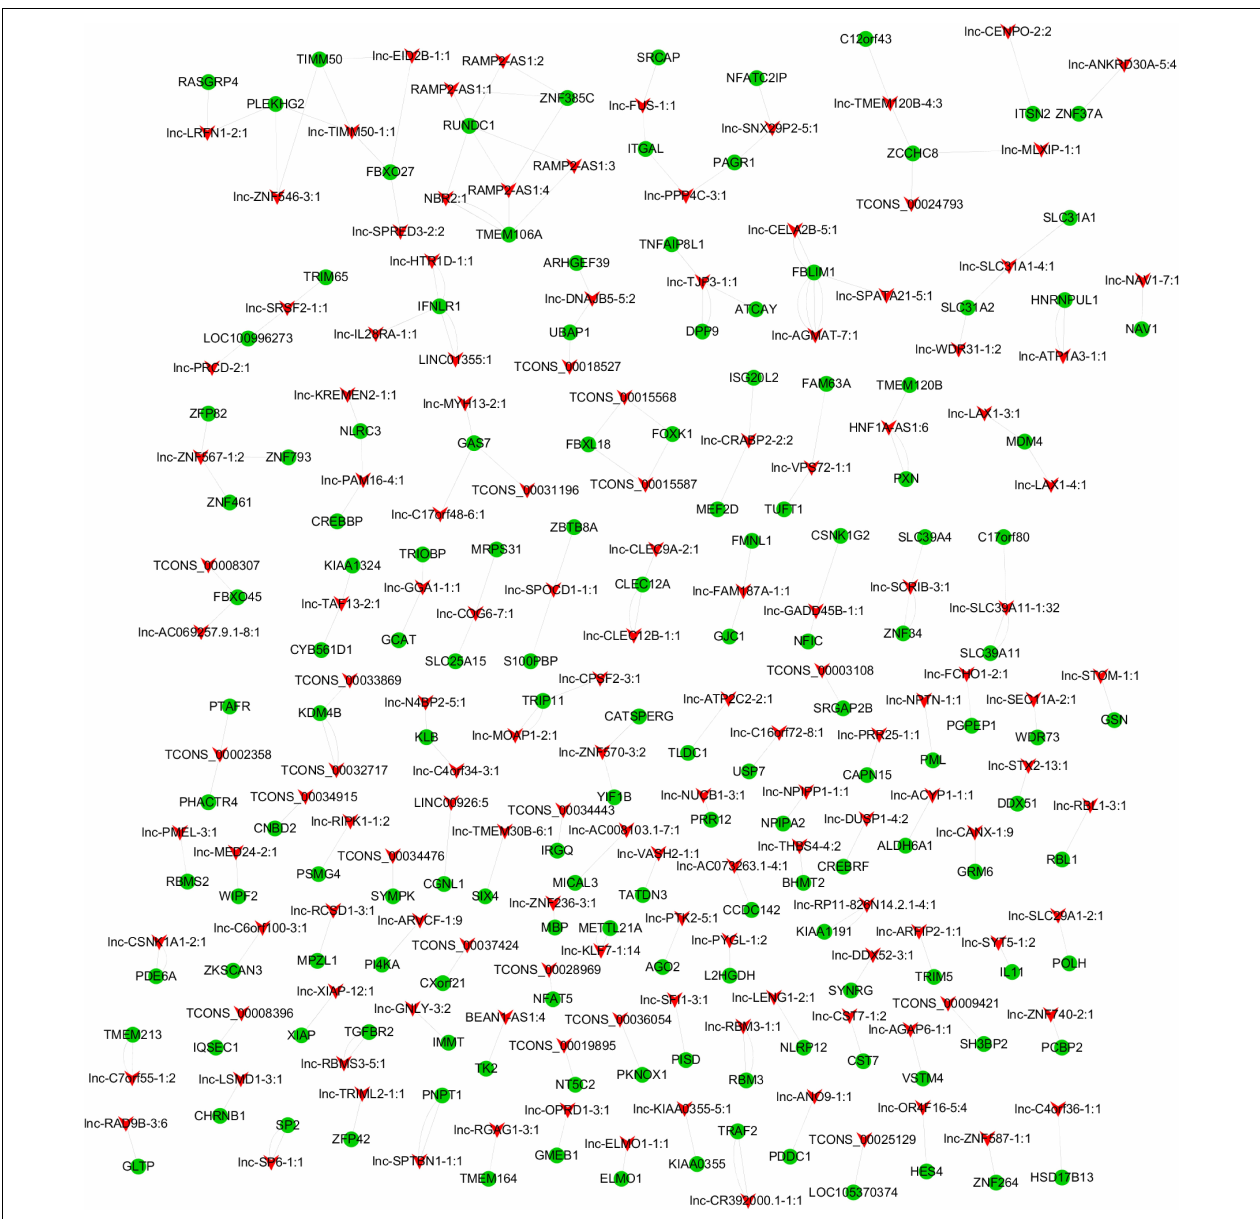
FIGURE 4 | lncRNA-mRNA interaction network in a cis